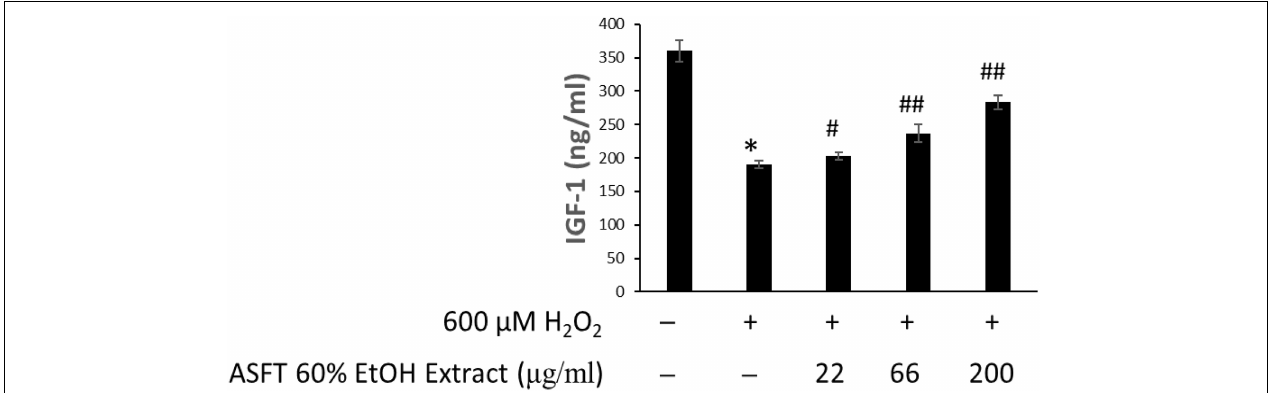
FIGURE 6 | Increasing effect of 60% ethanol extract from Alnus sibirica Fisch. ex Turcz (ASFT) on IGF-1 formation. The cells were pre-incubated with the indicated dose of 60% ethanol extract from ASFT and treated with H 2 O 2 . IGF-1 formation was measured as described in “Materials and Methods” following the manufacturer’s instructions. Data were expressed as mean ± SD. * P < 0.01 vs normal group. # P < 0.05 and ## P < 0.01 vs H 2 O 2 -treated group. Data were expressed as representative results from three independent experiments. +, present; –,